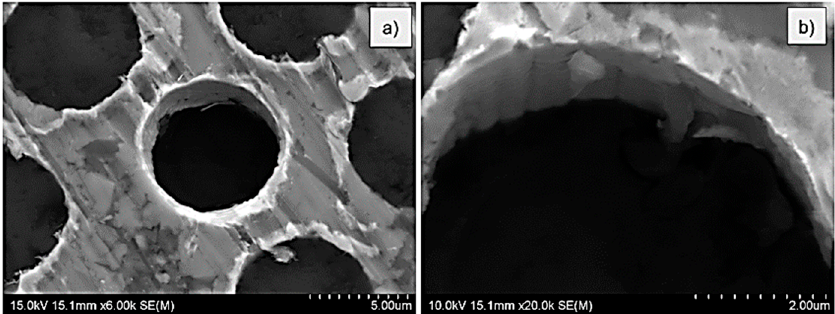
Figure 7. Top surface SEM images of the MMC3 sample after push-out tests: ( a ) BSE mode; ( b ) SE mode.